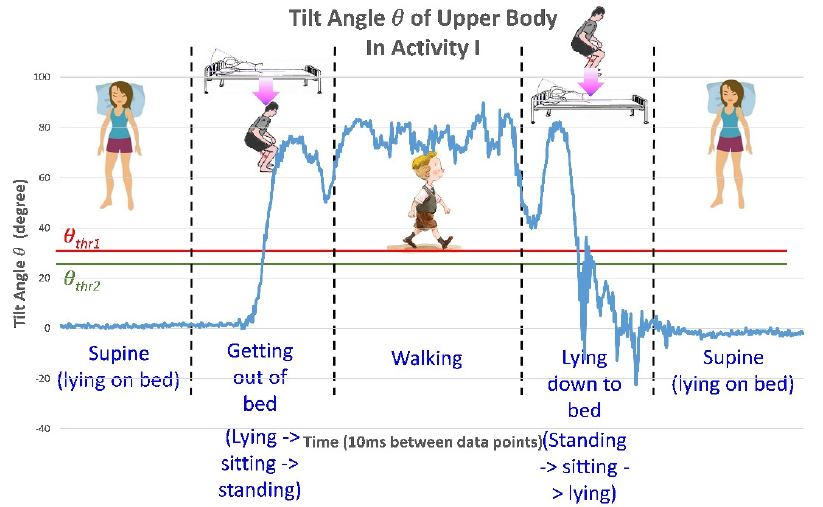
Figure 13. The detected tilt angle θ during postural change in Activity I. The tester sat up, stood up, took several steps, and then lay down again in the supine position (Activity I).